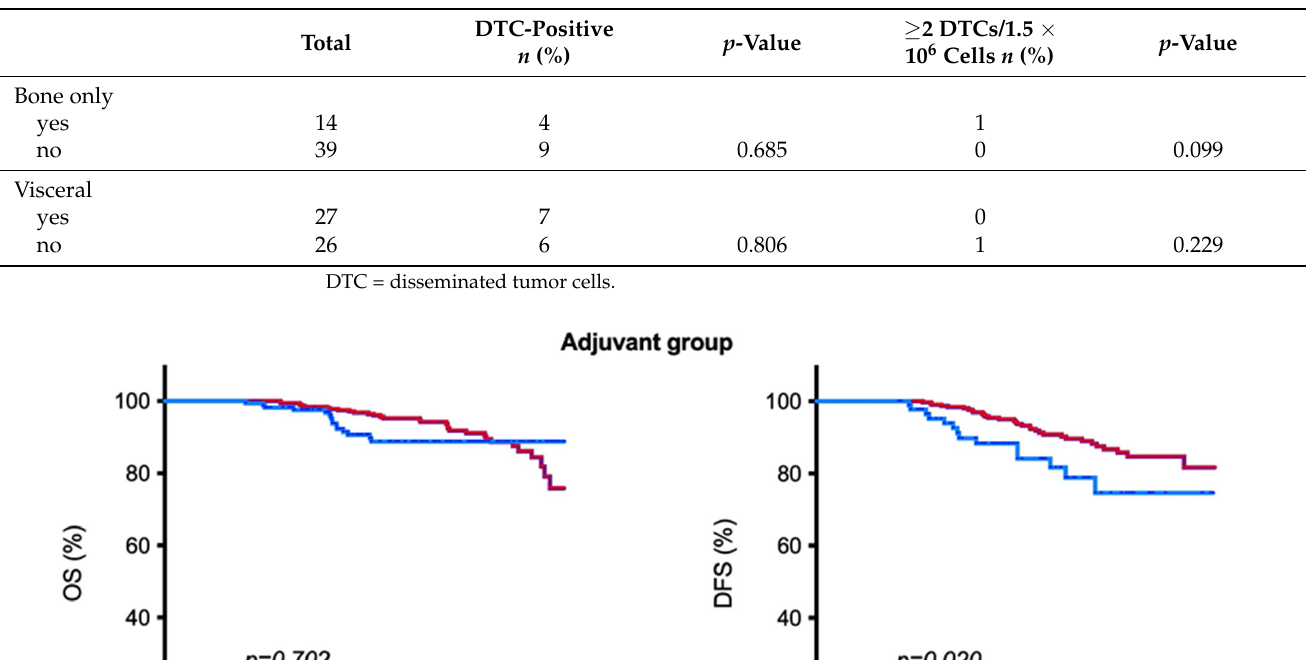
Table A3. Location of first distant recurrence in patients who received adjuvant chemotherapy.